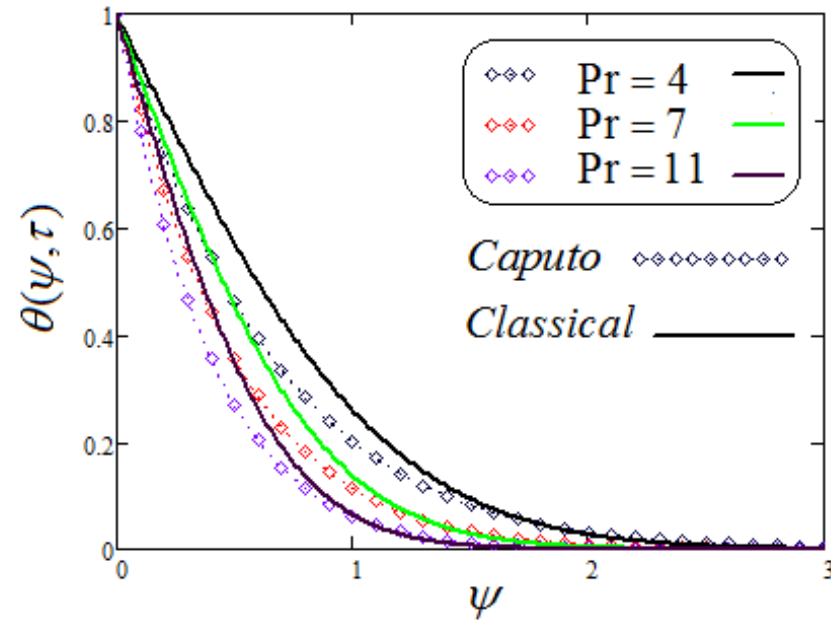
Figure 9. Trace of temperature comparison for dissimilar values of Pr .